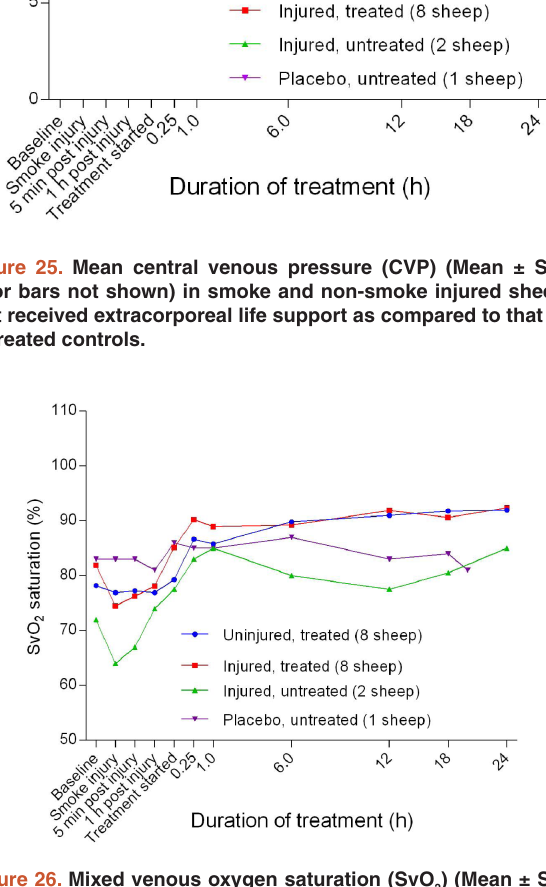
) (Mean ± SD, 2 Figure 28. Stroke volume (Mean ± SD error bars not shown) in smoke and non-smoke injured sheep that received extracorporeal life support as compared to that in untreated